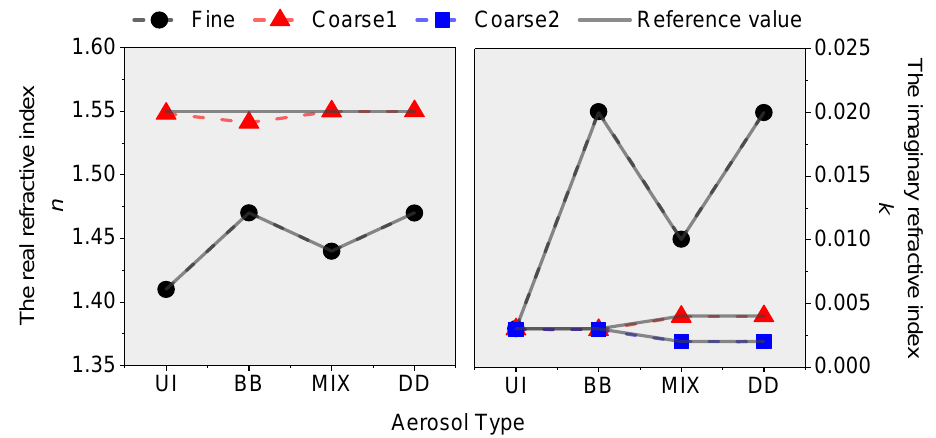
Figure 3. Estimated modal aerosol refractive indices of different aerosol models under error free conditions; fine, coarse1, and coarse2 refer to the fine-mode, coarse-mode at 0.44 µ m, and coarse-mode at 0.67–1.02 µ m refractive index, respectively.